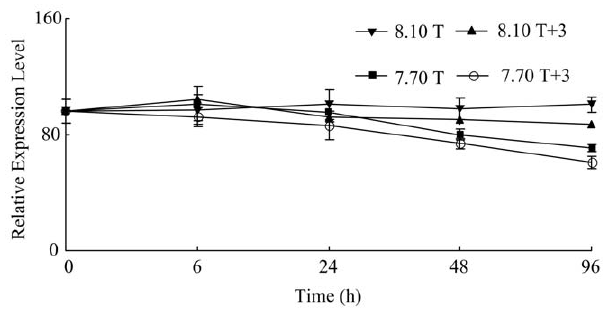
Figure 1. Real-time PCR analysis of expression of aspein in response to elevated temperature and declined pH.